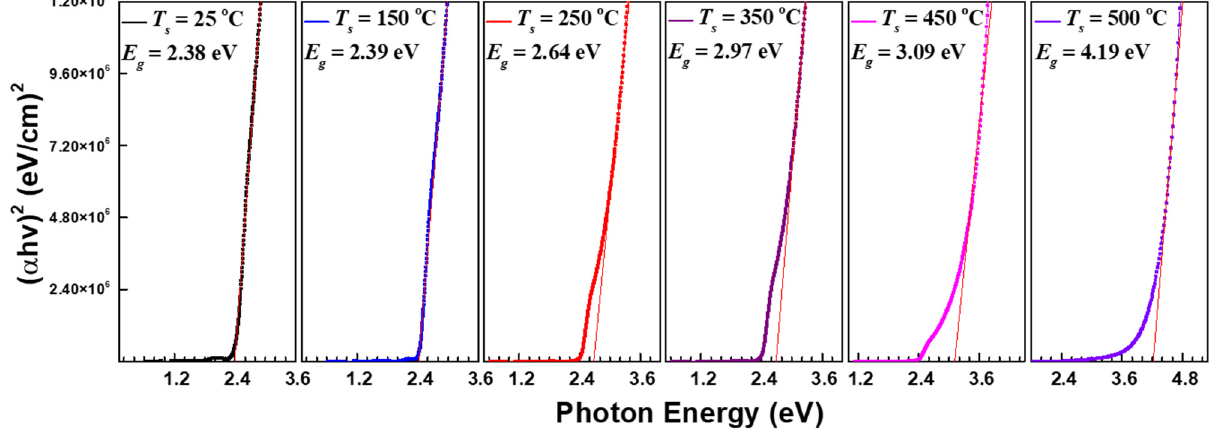
Figure 4. Energy band gap of CdS thin films as determined by transmittance spectroscopy.